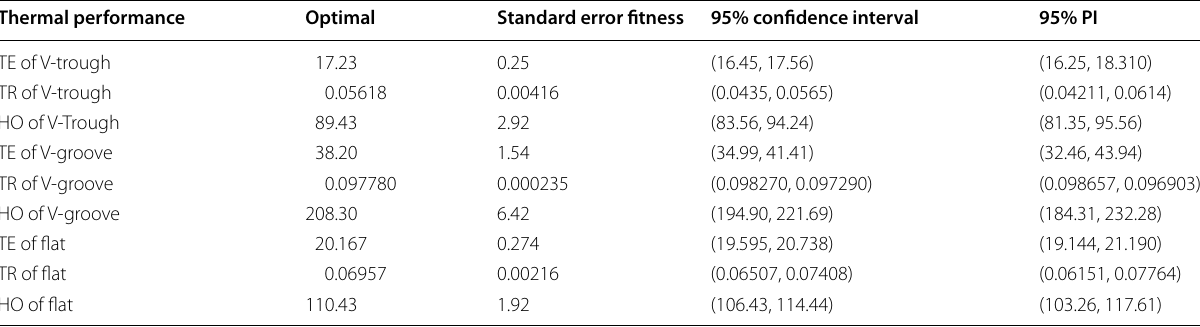
Table 7 Confirmation of experiment results